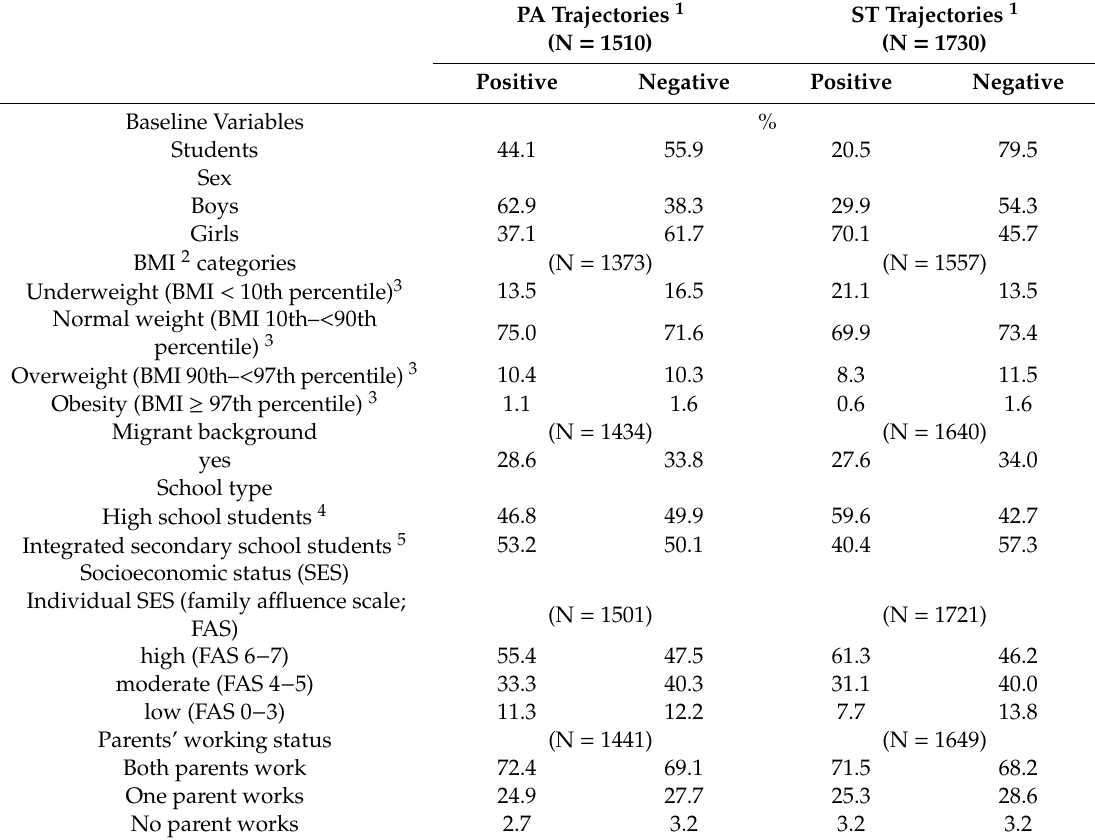
Table 4. Physical activity and screen time trajectories among 7th grade to 9th grade